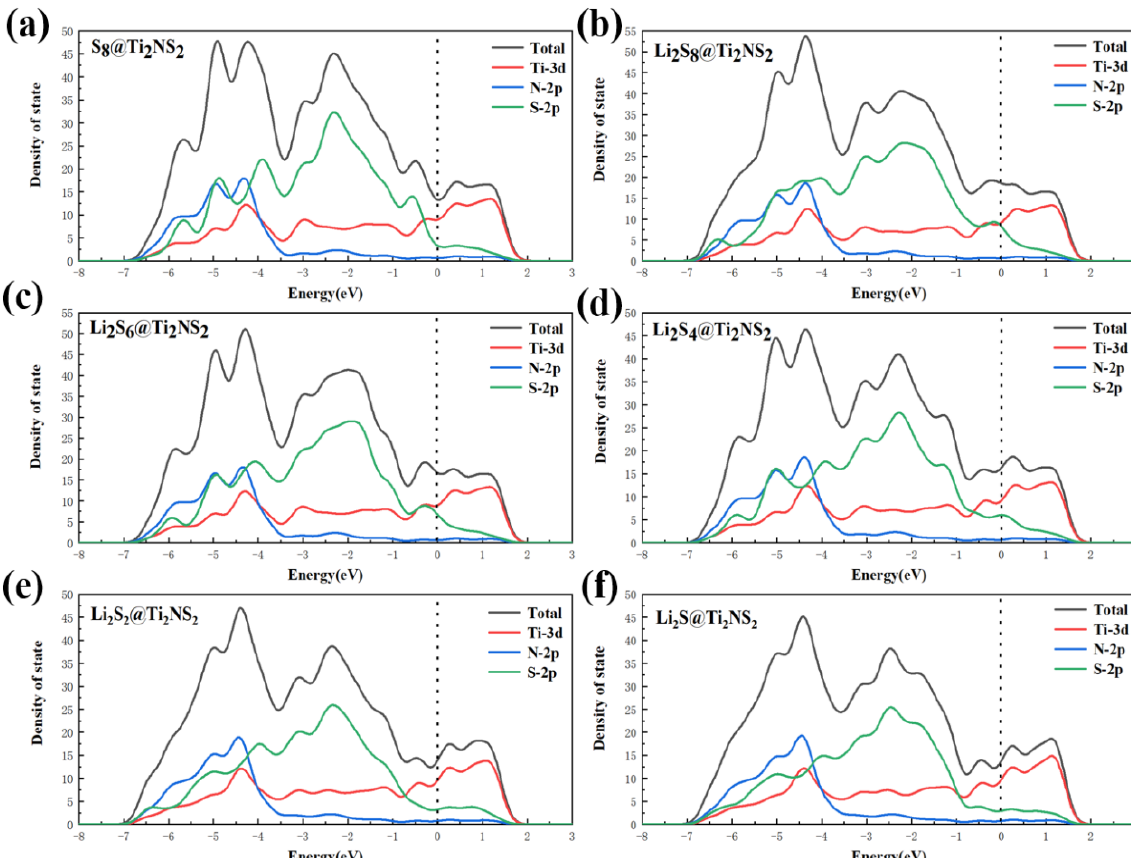
2 S x (x = 2, 4, 6) species on Ti 2 NS 2 .